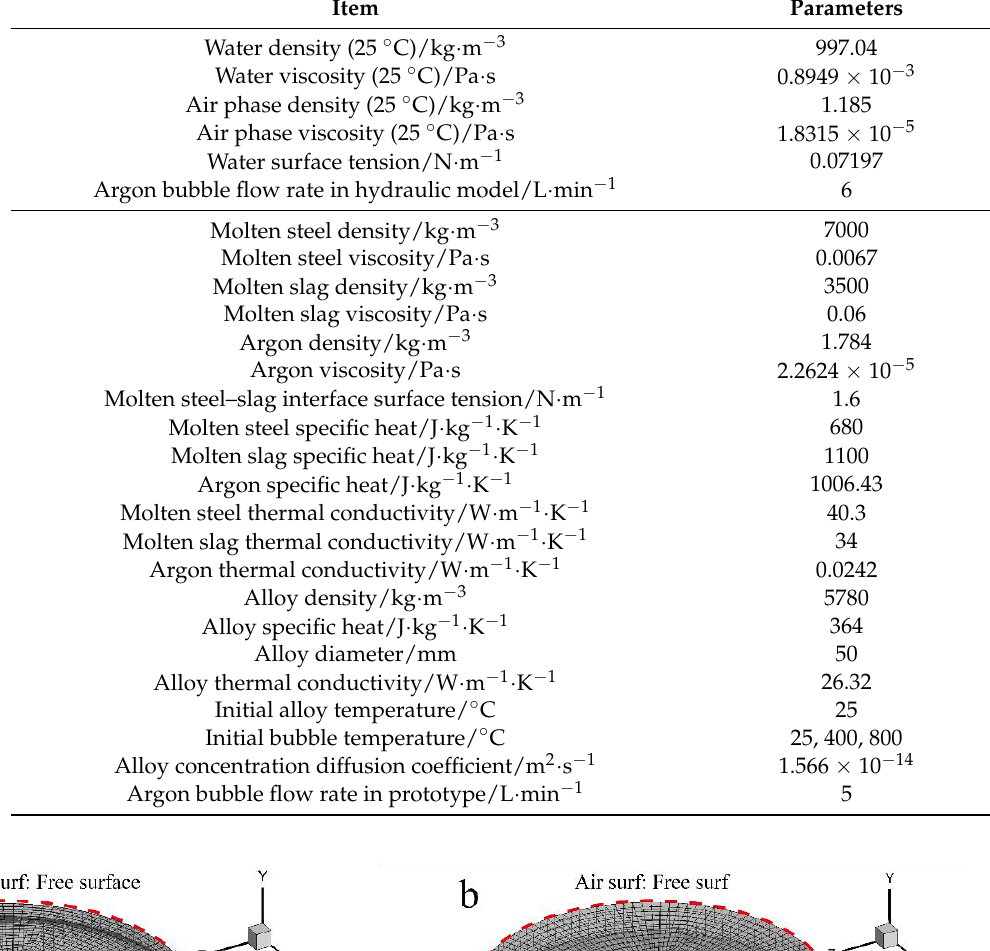
Table 2. Relevant parameters in the numerical simulation.